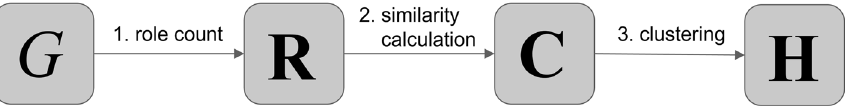
Fig. 2 Procedure of role